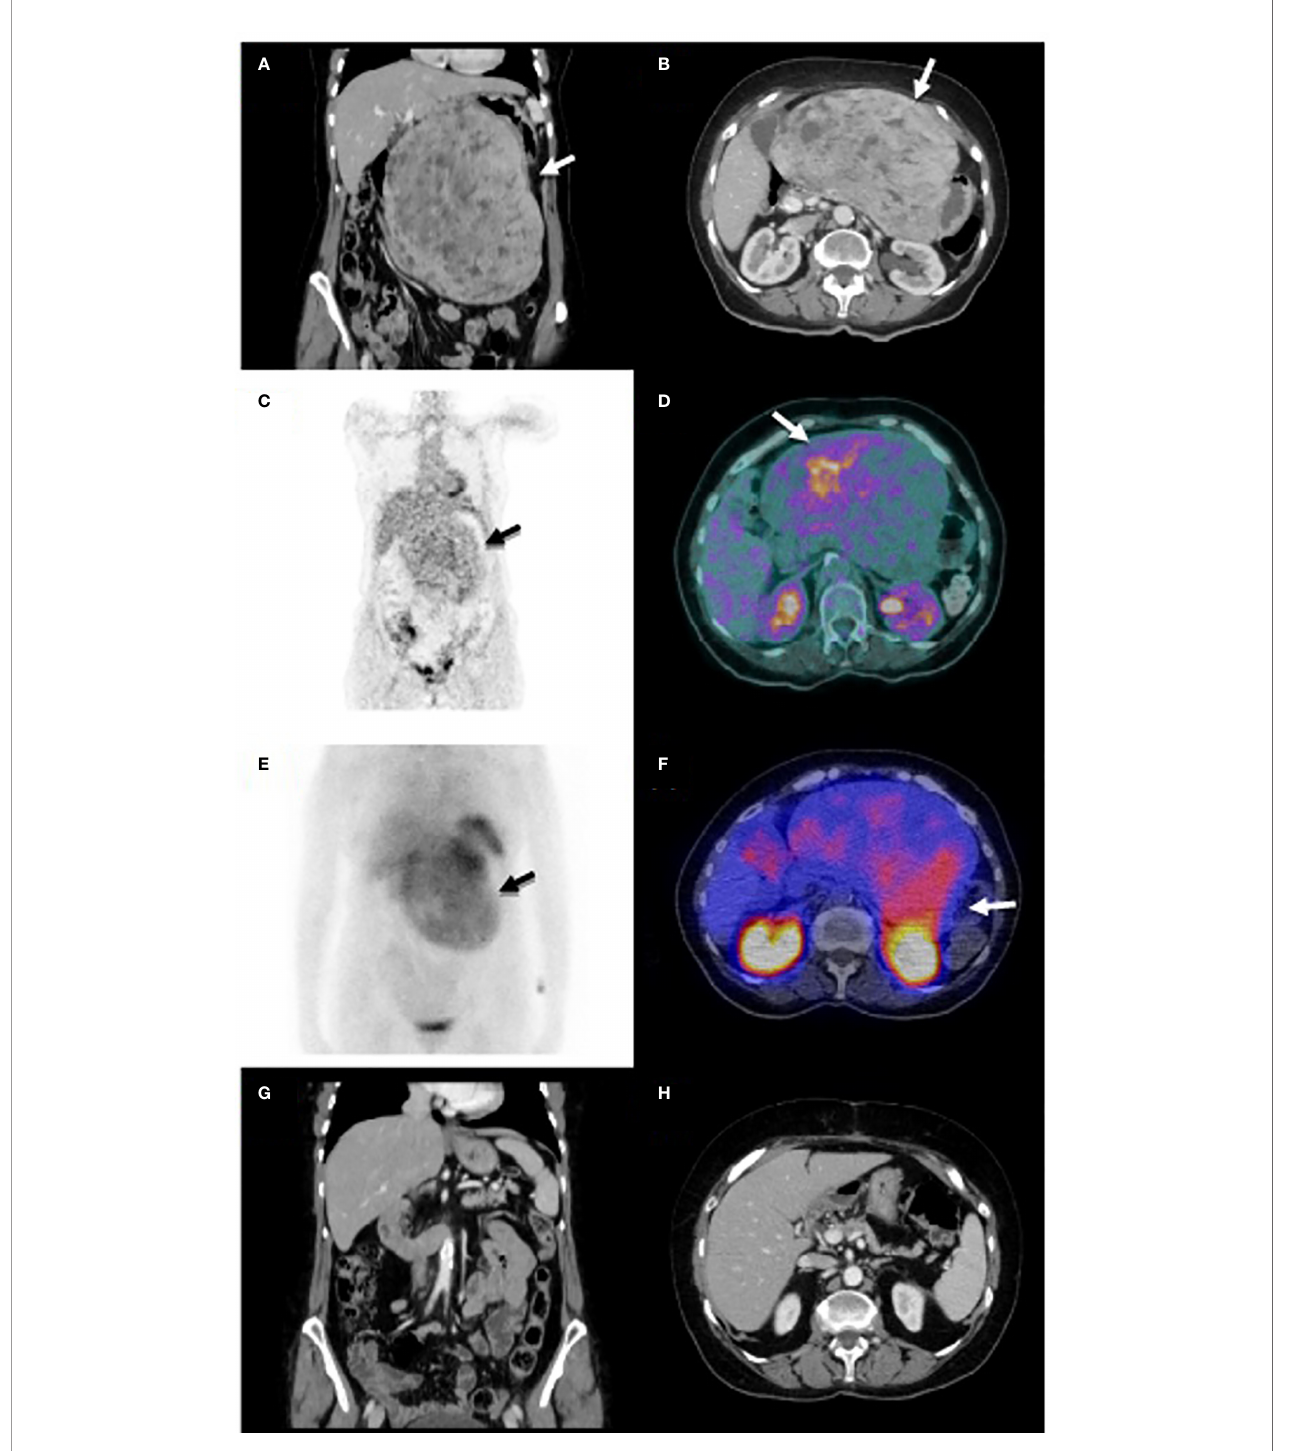
FIGURE 1 | Coronal and axial CT views at diagnosis (A, B) show an abdominal solid mass (23x13x18 cm), with several necrotic-cystic zones, closely located to the lesser curvature of the stomach, which displaced the duodenum, pancreas, aorta and cave vein. Coronal and axial images of 18-FDG PET/CT scan (C, D) reveal increased metabolic activity in the whole mass. Coronal and axial images of somatostatin receptor scintigraphy SPECT/CT show increased expression of somatostatin receptors (E, F) . Coronal and axial images of CT after surgery show complete tumor resection (G, H)